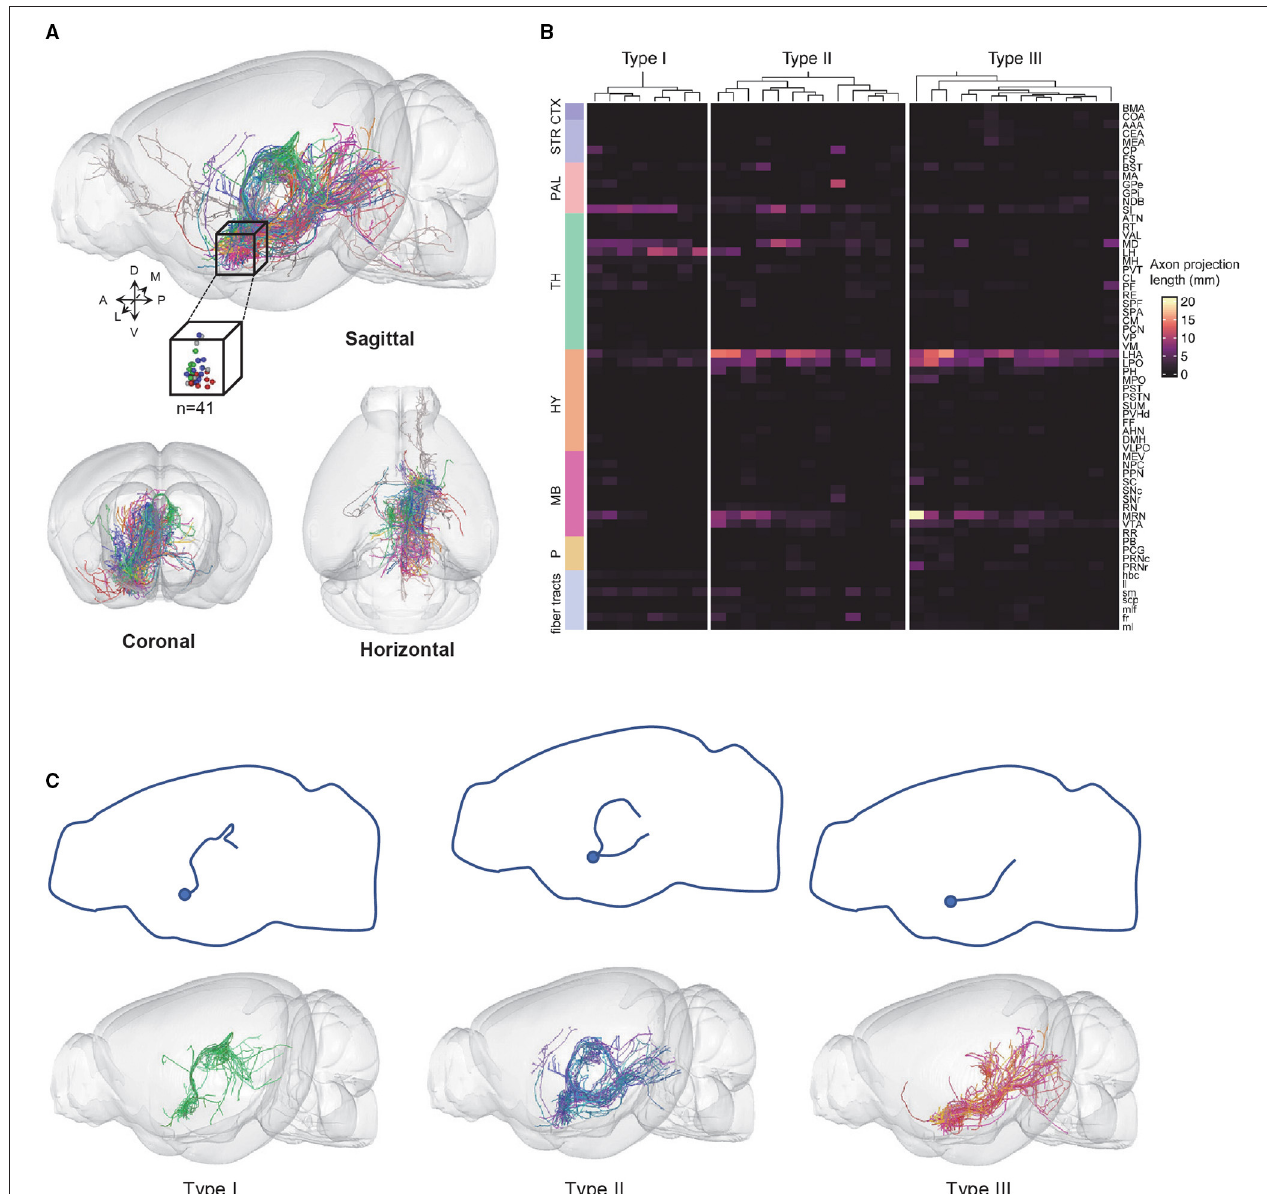
FIGURE 2 | VP neurons are classified into three types based on axonal projection patterns. (A) 3D views of 41 fully reconstructed VP neurons (top: sagittal view with the cube representing the somatic location; bottom: coronal and horizontal views). (B) The axonal fiber density of 3 VP neurons types in the entire brain. Columns represent individual neurons and rows represent brain regions; fiber tracts. (C) The projection routes of the three types of VP neurons. The top panels show a projection route schematic diagram. The bottom panels show the overlapped views of the individual VP neurons. CTX, cerebral cortex; STR, striatum; PAL, pallidum; TH, thalamus; HY, hypothalamus; MB, midbrain; P,